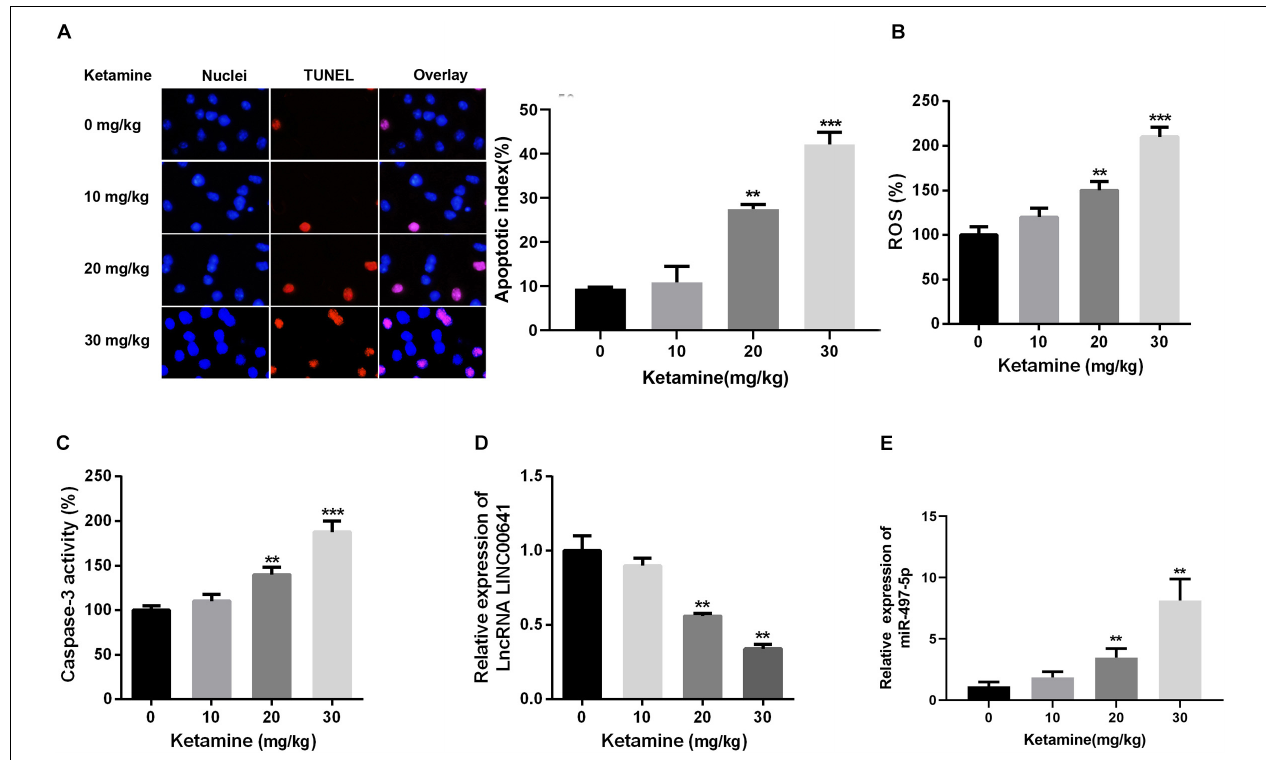
FIGURE 1 | High-concentration of ketamine-induced neuron apoptosis and down-regulation of LINC00641 in vivo . Rat hippocampus treated with different concentrations of ketamine (0, 10, 50, and 100 mg/kg). (A) TUNEL was employed to analyze the neuronal apoptosis and apoptotic index, the nuclei were blue, the apoptotic cells were red, and the apoptotic index was calculated by TUNEL positive neurons/total neuron number. (B) ROS levels in rat brain were determined under treatment of different concentrations of ketamine. (C) The activity of caspase-3 in rat brain was measured under the treatment of different concentrations of ketamine. (D,E) The relative expression of LINC00641 and miR-497-5p in rat brain treated with different concentrations of ketamine was analyzed by qRT-PCR. ** P < 0.01 and *** P < 0.001 compared with 0 mg/kg